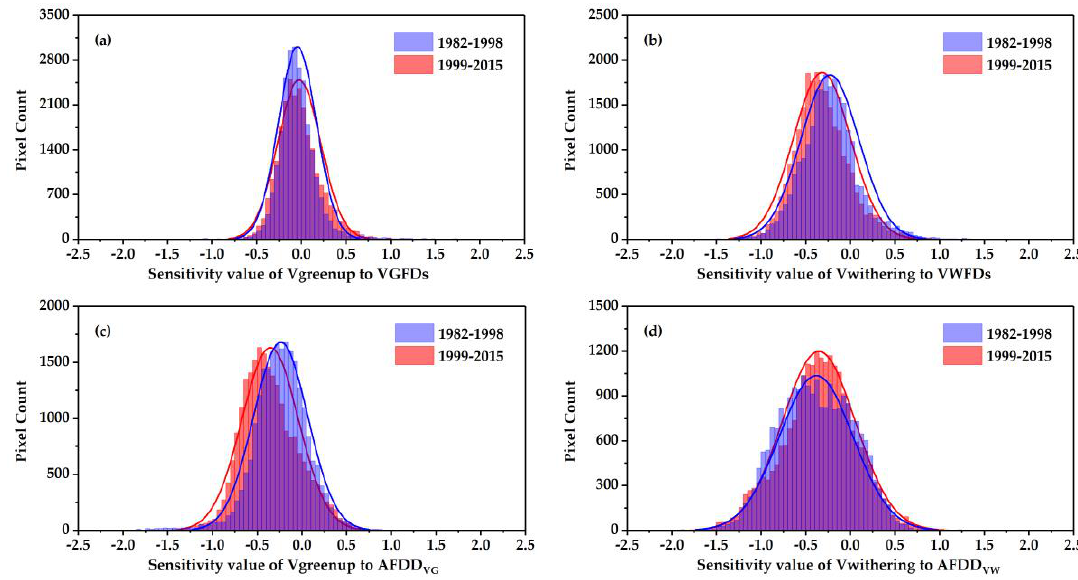
Figure 7. Sensitivity of Vgreenup and Vwithering to frost during the growing season: ( a ) VGFDs and Vgreenup; ( b ) VWFDs and Vwithering; ( c ) AFDD VG and Vgreenup; ( d ) AFDD VW and Vwithering.